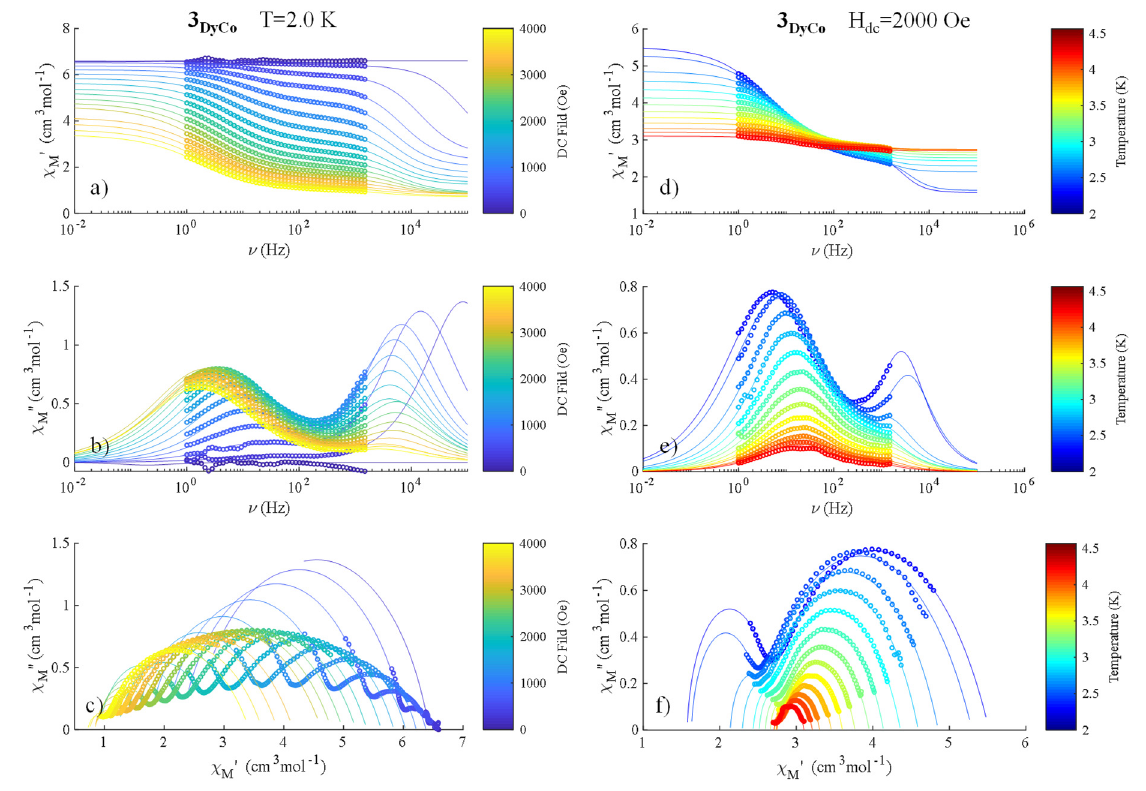
Figure 8. Field dependence ( left , a , b ) and temperature dependence ( right , d , e ) of ac susceptibility ( H ac = 3.0 Oe) and Cole– Cole plots, ( c , f ), for 3 DyCo at the indicated temperatures and fields. The solid lines represent the best fits according to the generalized Debye model for two relaxations processes (Equations (S1) and (S2)).